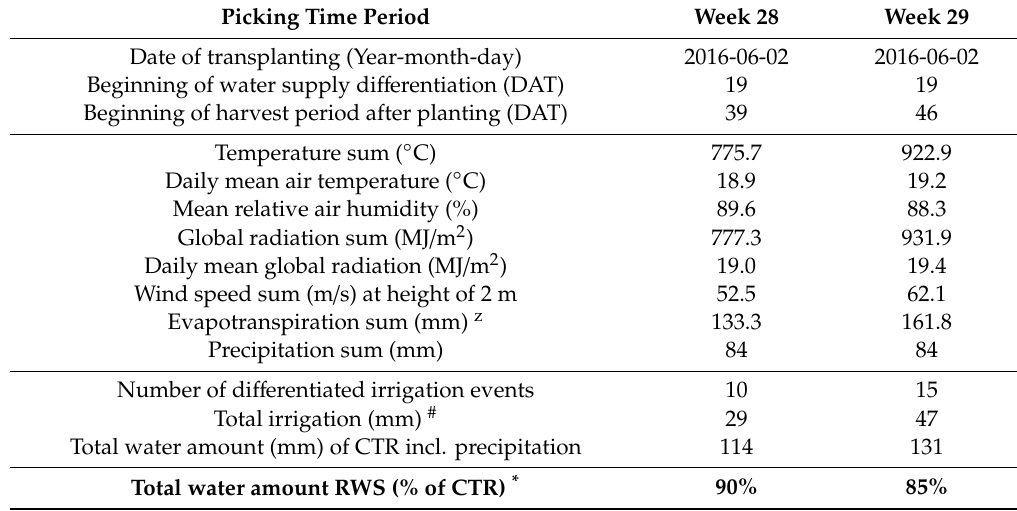
Total water amount (mm) of CTR incl.